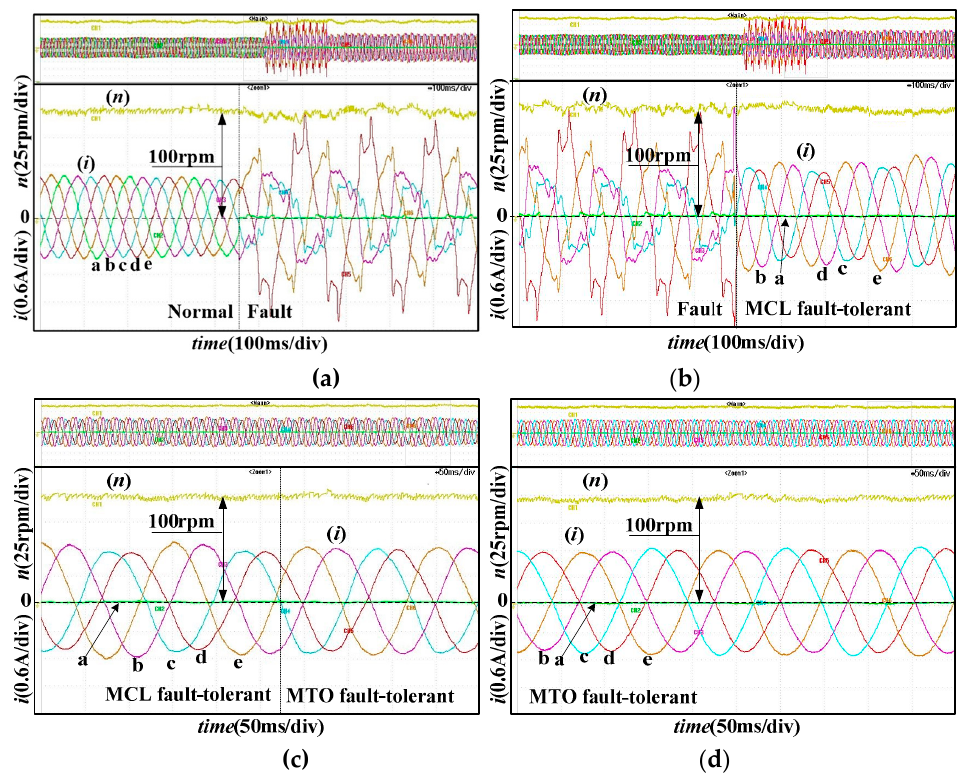
Figure 12. Fault-tolerant current and speed waveforms with A open-phase condition: ( a ) normal to open-fault; ( b ) open-fault to MCL; ( c ) MCL to MTO; ( d ) MTO.